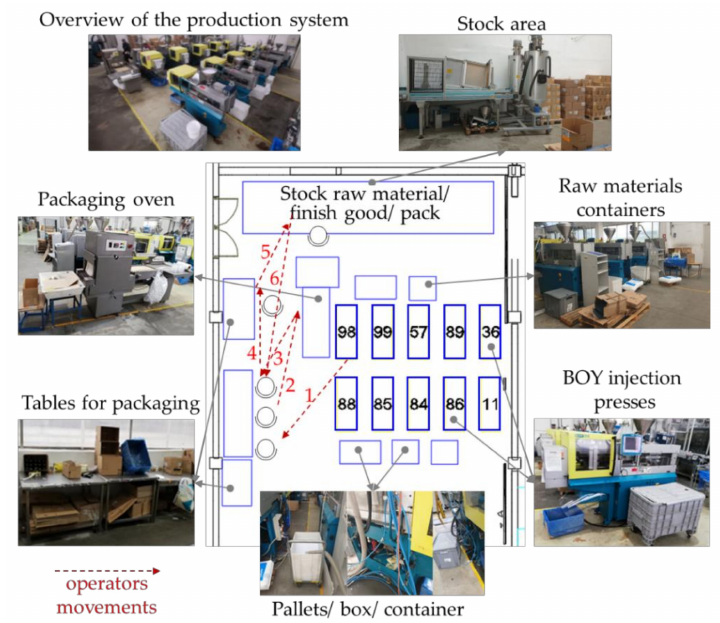
Figure 12. Initial layout and resources of the production system. The production flow includes four stages: (1) supply of raw materials, (2) injection process, (3) product packaging, and (4) storage; see Figure 13.